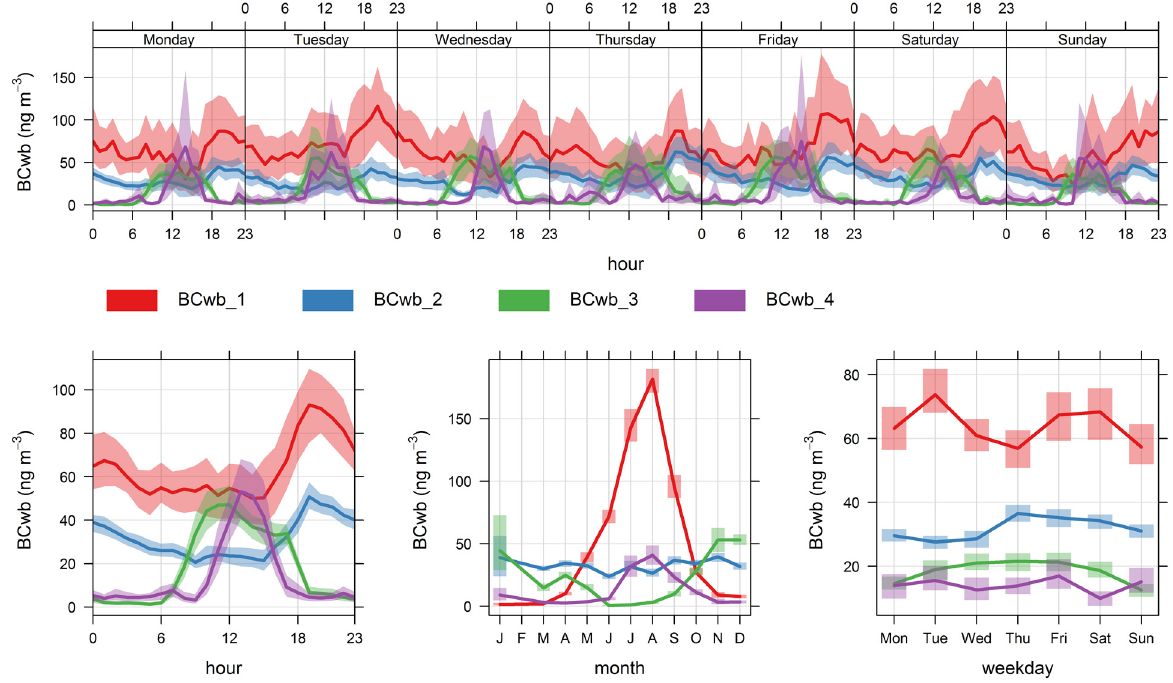
Figure 7. Time variability plot for the four fuzzy clusters' contributions to BC wb .